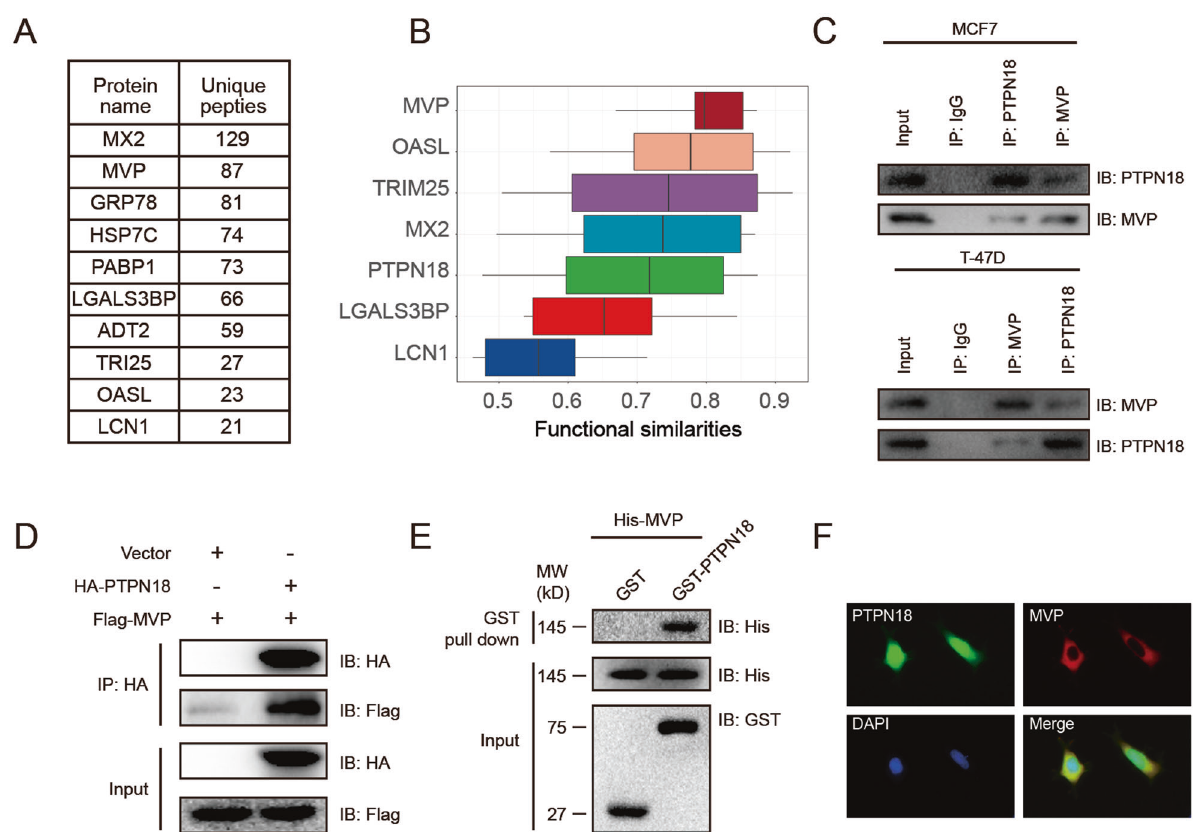
Fig. 1 PTPN18 interacts with MVP in vitro and in vivo. A Proteins identi fi ed in the immunopuri fi ed PTPN18 complexes by mass spectrometry. B Summary of functional similarities of the PTPN18 interactome in MCF7 cells. C The physical association between endogenous PTPN18 and MVP was validated using immunoprecipitation (IP) in MCF7 and T-47D cells. D Co-IP showed the interaction between ectopic PTPN18 and MVP in 293 T cells. E GST pull-down assay with GST-tagged PTPN18 and His-tagged MVP. F Representative immuno fl uorescence images showing the colocalization of PTPN18 (green) and MVP (red) in MCF7